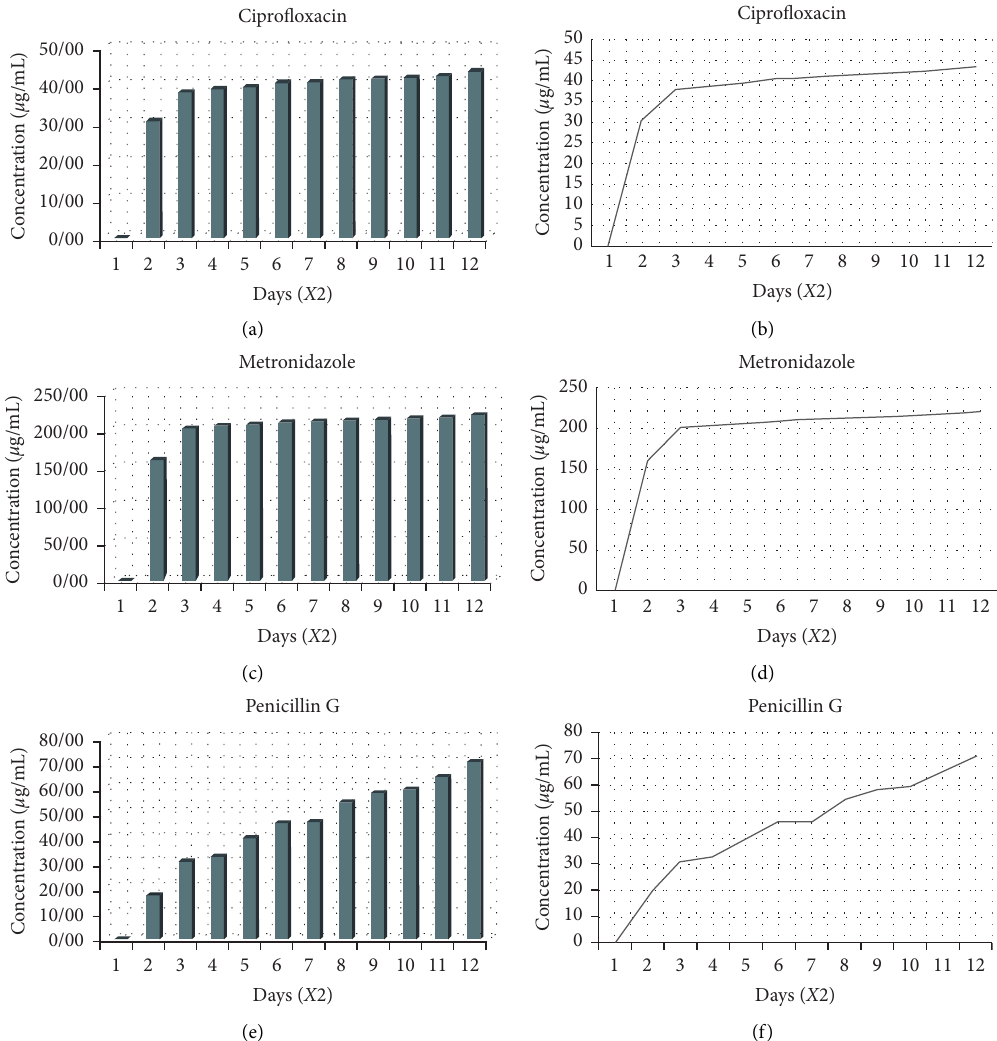
Figure 5: The in vitro drug release profile of the three antibiotics from PPCMs over 21 days. The cumulative drug-release concentration of the antibiotics in “Phosphate Buffered Saline (PBS)” is expressed in µ g/mL. As it can be seen in the profile, ciprofloxacin and metronidazole had a burst release in the first 4 days but reached a relative plateau on the other days. However, penicillin G continued its sustained release throughout the 21 days of the experiment ( Note. In the above profiles, “Days” should be multiplied by two, as indicated in the horizontal